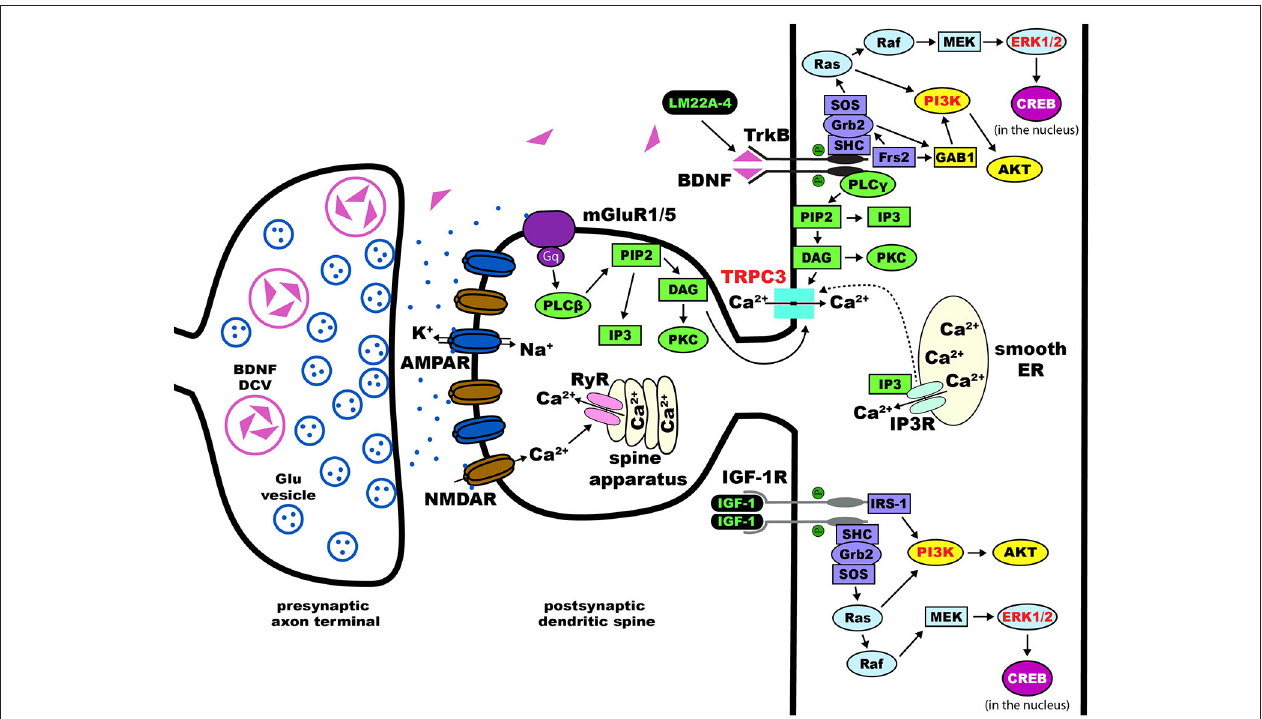
protein kinase; cAMP, cyclic adenosine monophosphate; CREB, cAMP response element-binding protein; DAG, diacylglycerol; Frs2, fibroblast growth factor receptor substrate 2; GAB1, GRB2-associated-binding protein 1; Grb2, growth factor receptor-binding protein 2; IGF-1, insulin-like growth factor 1; IGF-1R, IGF-1 receptor; IP3, inositol triphosphate; MAPK, mitogen-activated protein kinase; MEK, MAPK//ERK kinase; NMDAR, N -methyl-D-aspartate receptor; PI3K, phosphoinositide 3-kinase; PIP2, phospohatidylinositol 4, 5 bisphosphate; PKC, protein kinase C; PLC γ , phospholipase C- γ ; Raf, proto-oncogenic serine/threonine protein kinase; Ras, rat sarcoma proto-oncogenic G-protein; SHC, SH-2-containing protein; SH-2, src homology domain 2; SOS, nucleotide exchange factor son of sevenless; TrkB, tropomyosin related kinase B receptor; TRPC, transient receptor potential